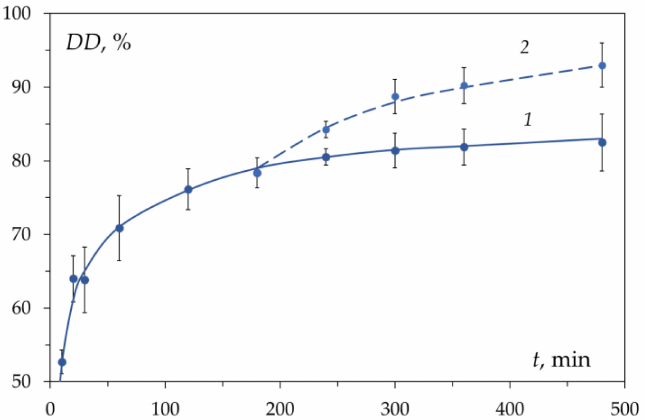
Figure 18. The kinetic curve of chitin deacetylation in 50 wt.% NaOH solution at T = 100 ◦ C without added water (1) and with the addition of water (2) 3 h after the start of the reaction to a NaOH concentration of 40 wt.%. Original